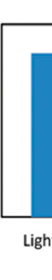
Figure 33. Electron spin resonance (ESR) spectra of ( a ) SrTiO 3 under N 2 ; ( b ) Rh/SrTiO 3 under N 2 ; ( c ) Rh/SrTiO 3 under UV N 2 , CO 2 , and CO 2 + CH 4 . Reprinted from [30].